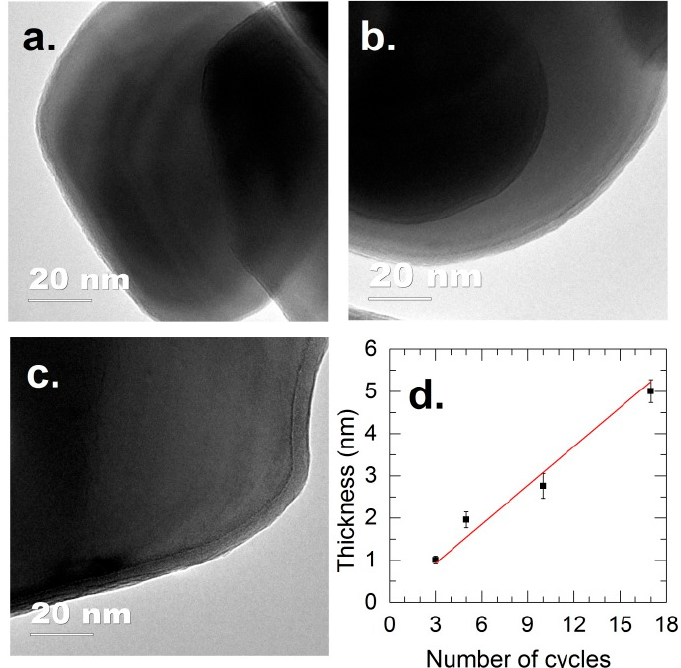
Figure 1. TEM images of Al 2 O 3 films deposited on anatase TiO 2 nanoparticles for ( a ) three cycles, ( b ) 10 cycles and ( c ) 17 cycles, and ( d ) the coating thickness as a function of the number of cycles.